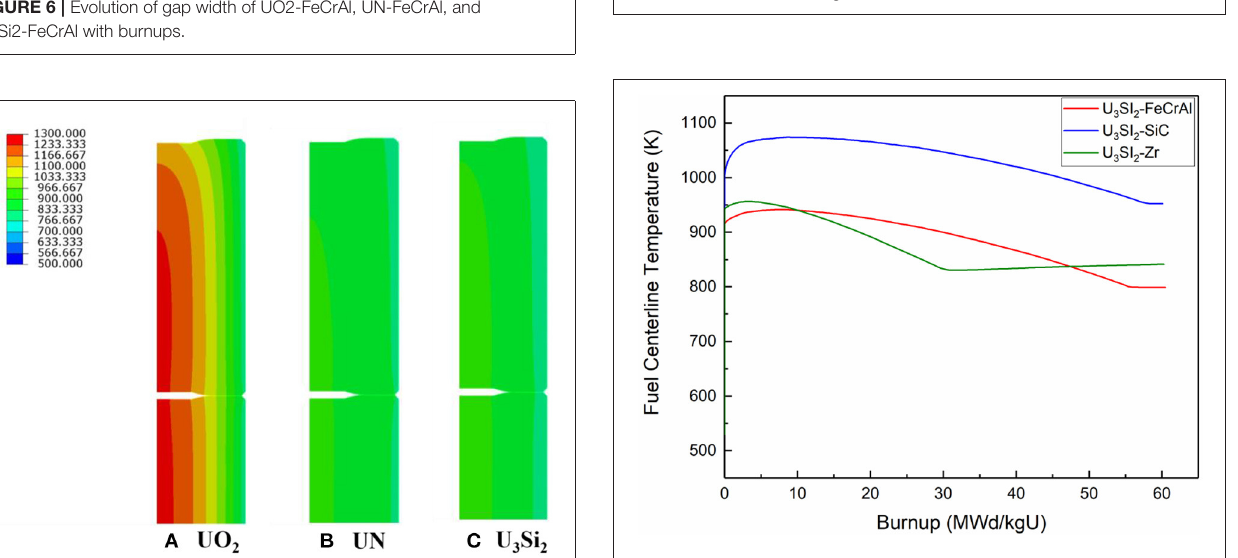
FIGURE 7 | Fuel temperature (K) of (A) UO 2 (B) UN, and (C) U 3 Si 2 at BOC with FeCrAl cladding.